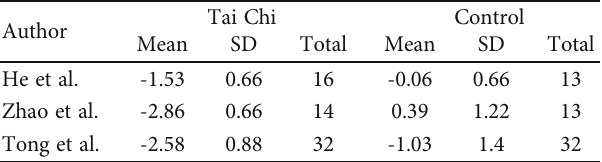
Figure 8: Forest plot of pain intensity of Tai Chi vs. control. Table 6: Oswestry disability index for Tai Chi for disability.